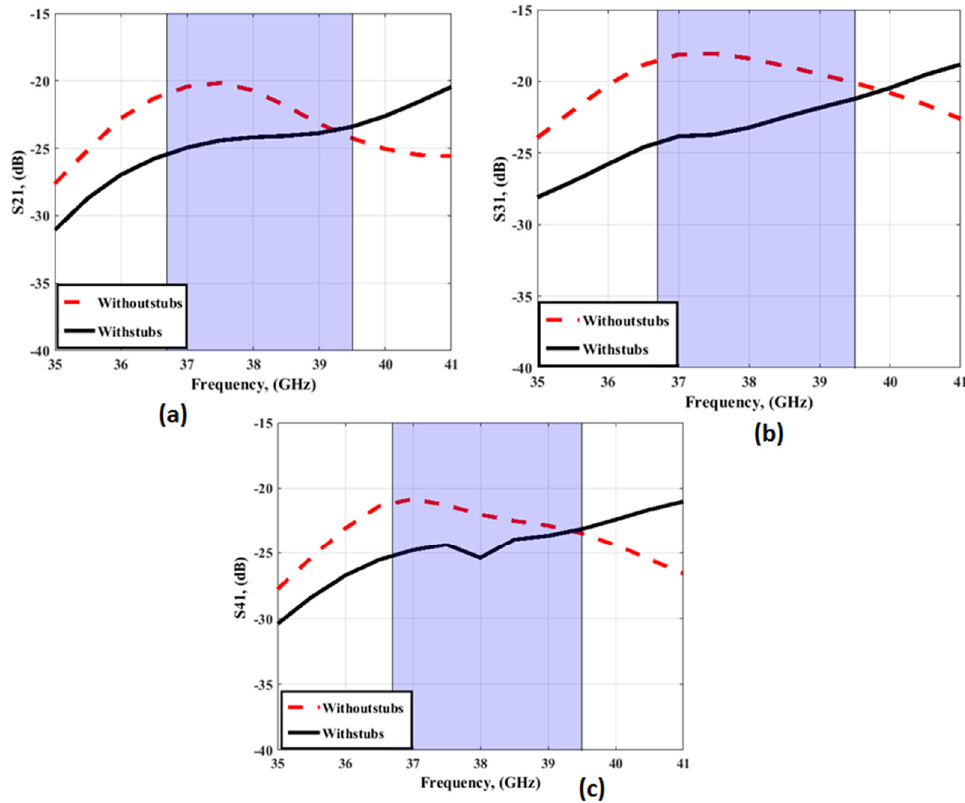
Figure 6. The simulated S 11 with/without stubs.